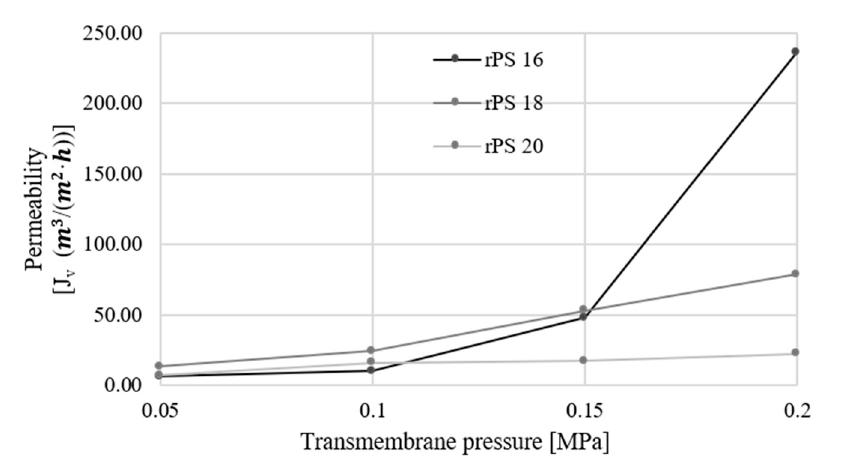
Figure 1. The permeability of the prepared membranes relative to transmembrane